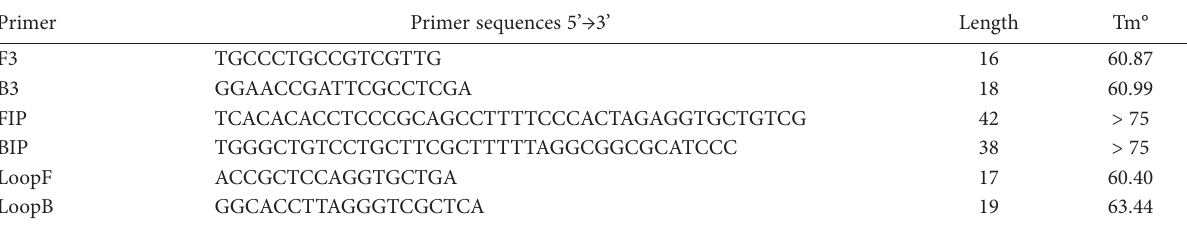
Table 2. LAMP primers used for the detection of Pleurostoma richardsiae . Primer Primer sequences 5’→3’